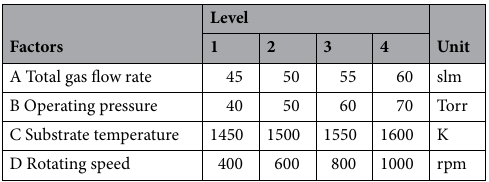
Table 1. Orthogonal factor and level table.